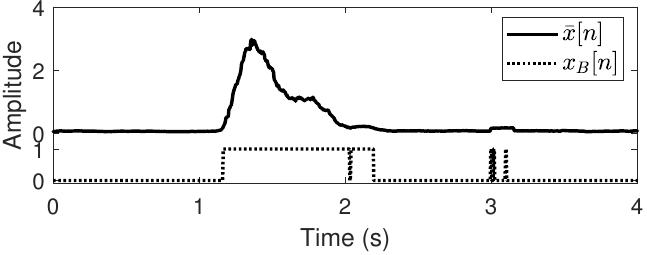
Figure 4. Binarized EMG using the modified CFAR